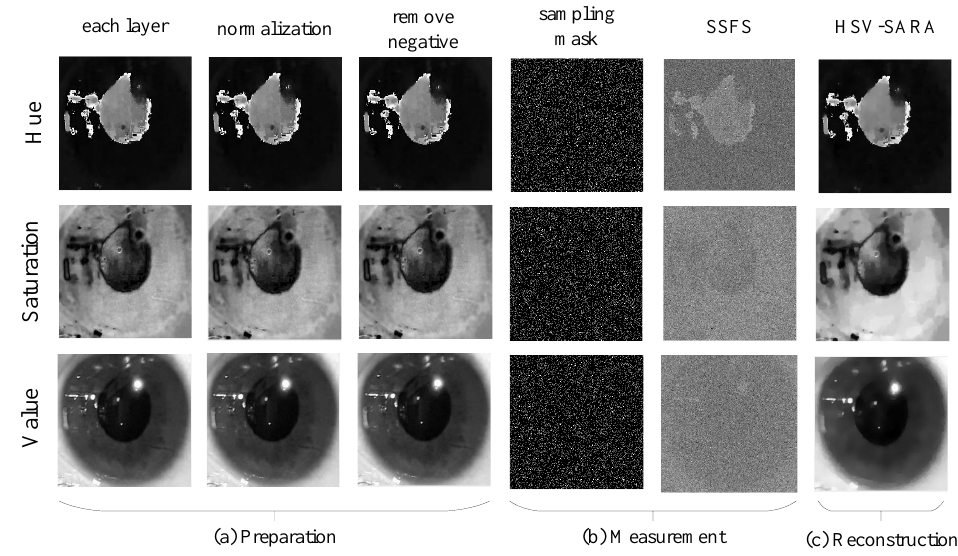
Figure 4. An example of visual representation in the proposed